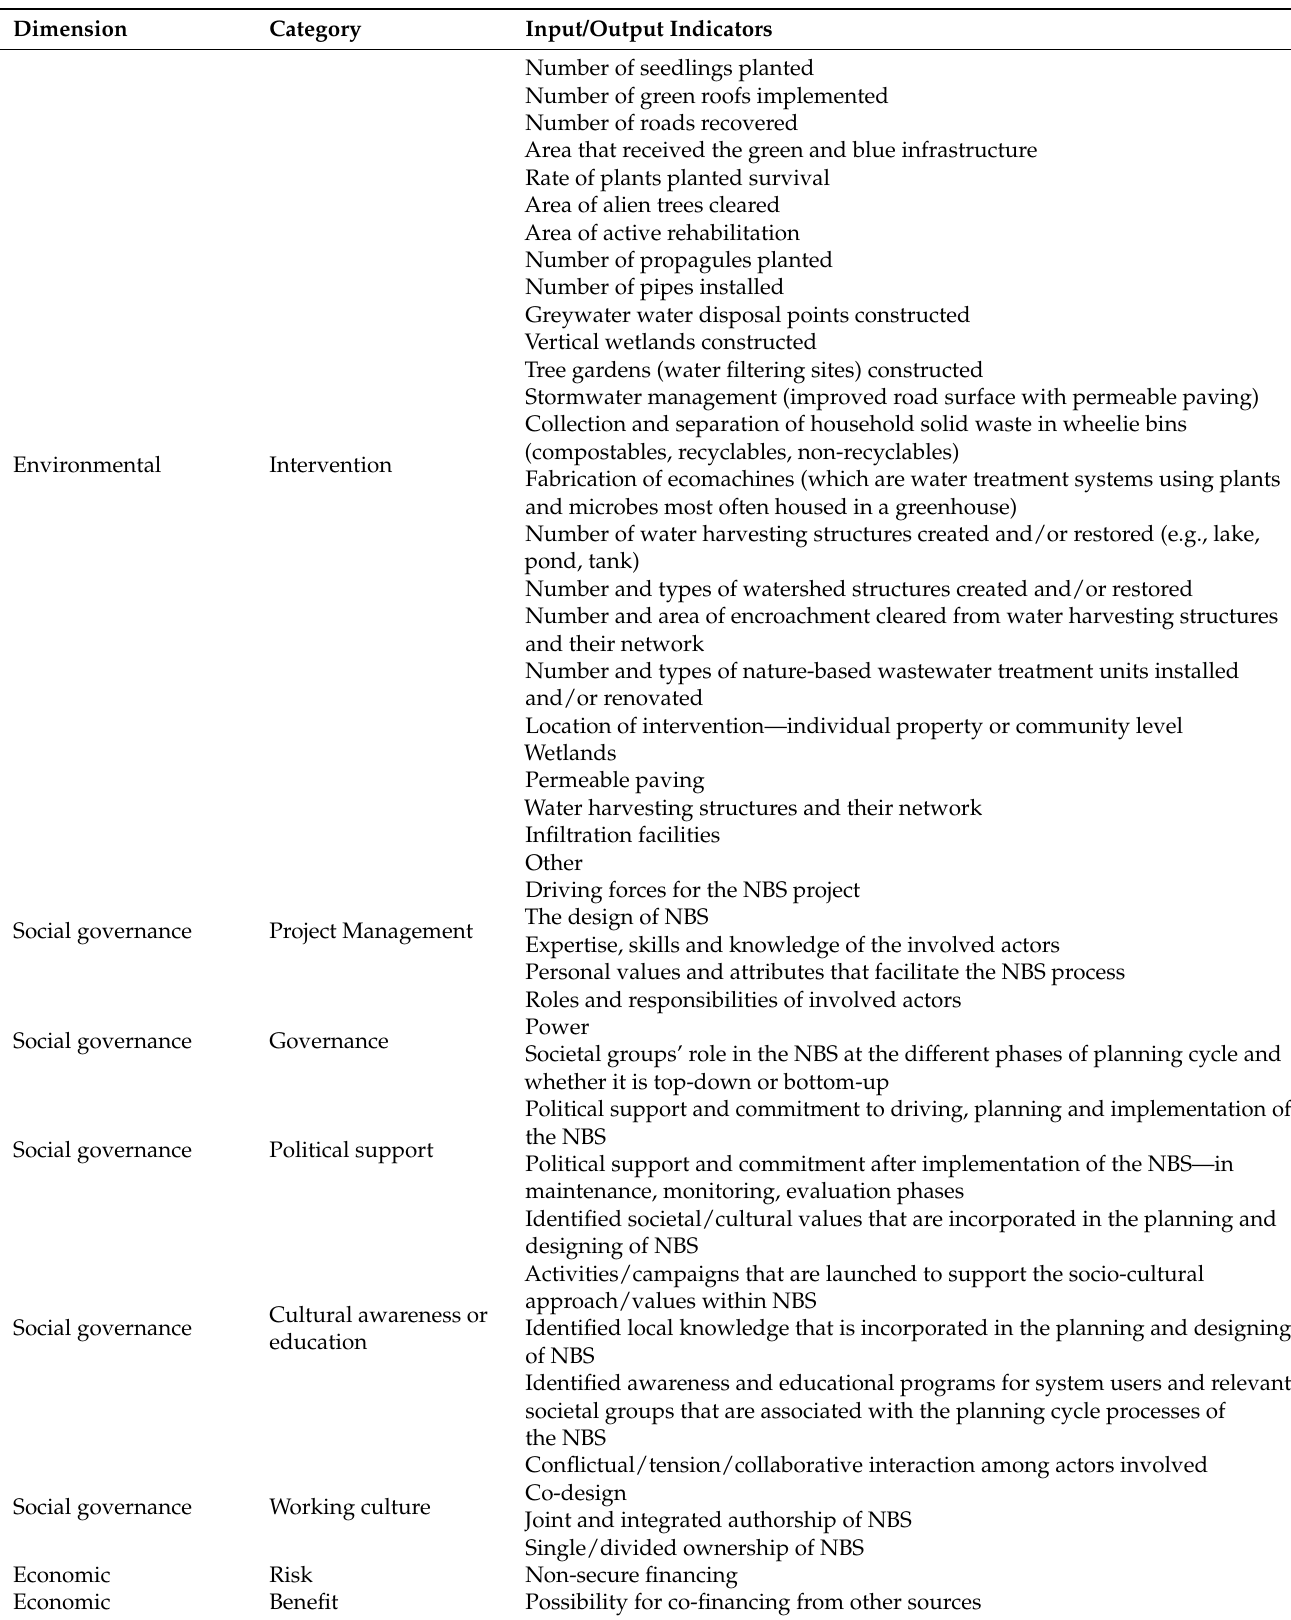
Table 1. Process indicators developed for the framework proposed by de Lima et al.,